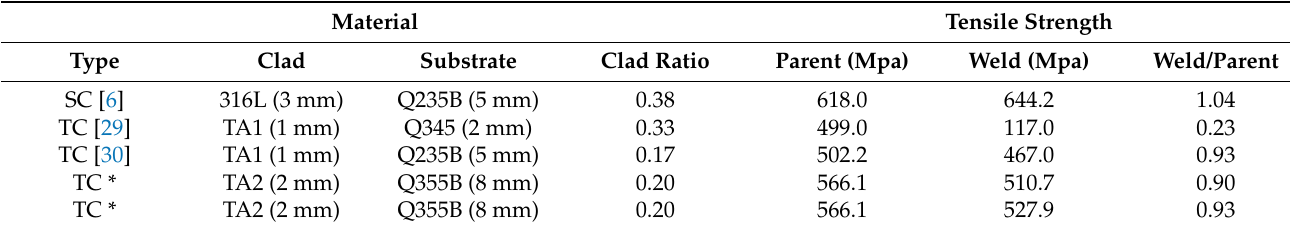
Table 11. Comparison of tensile strength on different weld joints of bimetallic